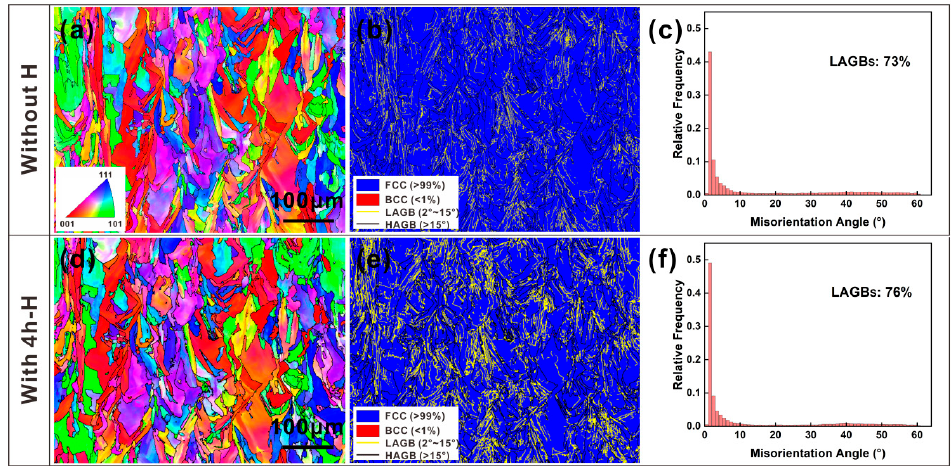
Figure 4. Quasi in situ EBSD maps of ( a – c ) uncharged sample and ( d – f ) H ‐ charged sample. ( a , d ) inverse pole figure (IPF) grain orientation maps, ( b , e ) phase maps with the LAGBs and HAGBs, ( c , f ) misorientation angle distribution maps. ( c , f ) misorientation angle distribution